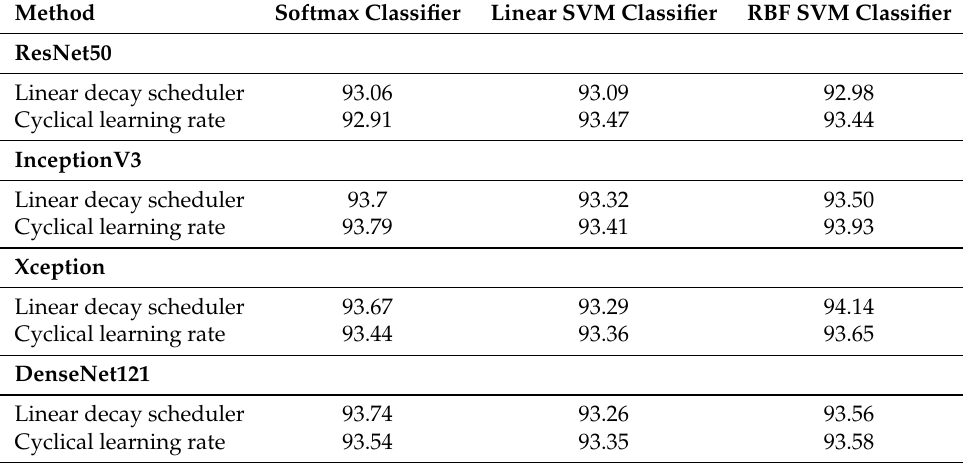
Table 2. Overall accuracy (%) of the proposed method with a 20%/80% train/test ratio of the AID dataset. The bold text highlights the best accuracy per